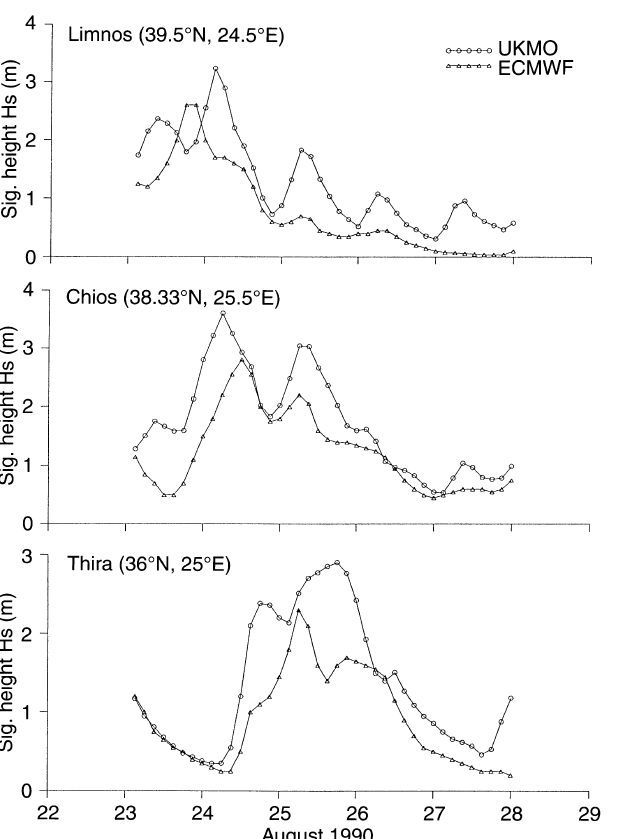
Fig. 6. Wave heights at specific grid points – AUT, August 1990 (UKMO v. ECMWF